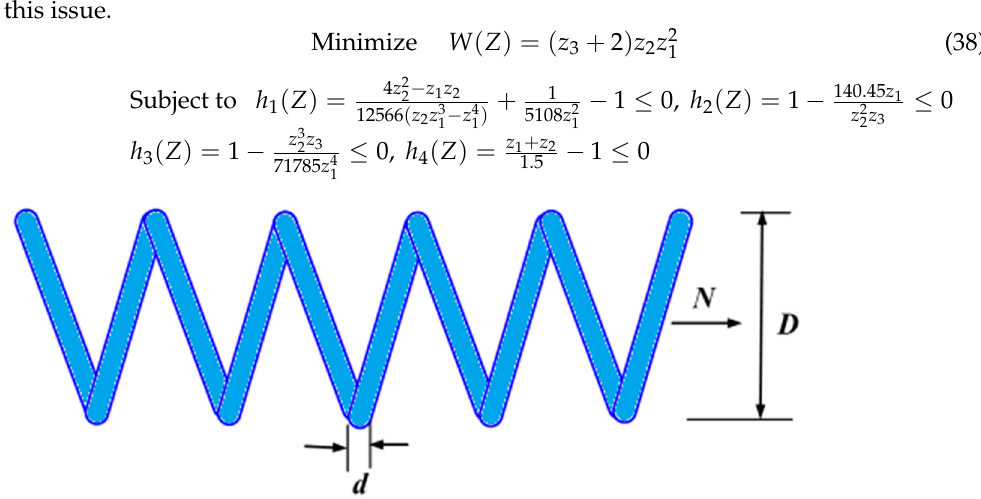
Figure 8. Sketch map of the tension/compression spring.